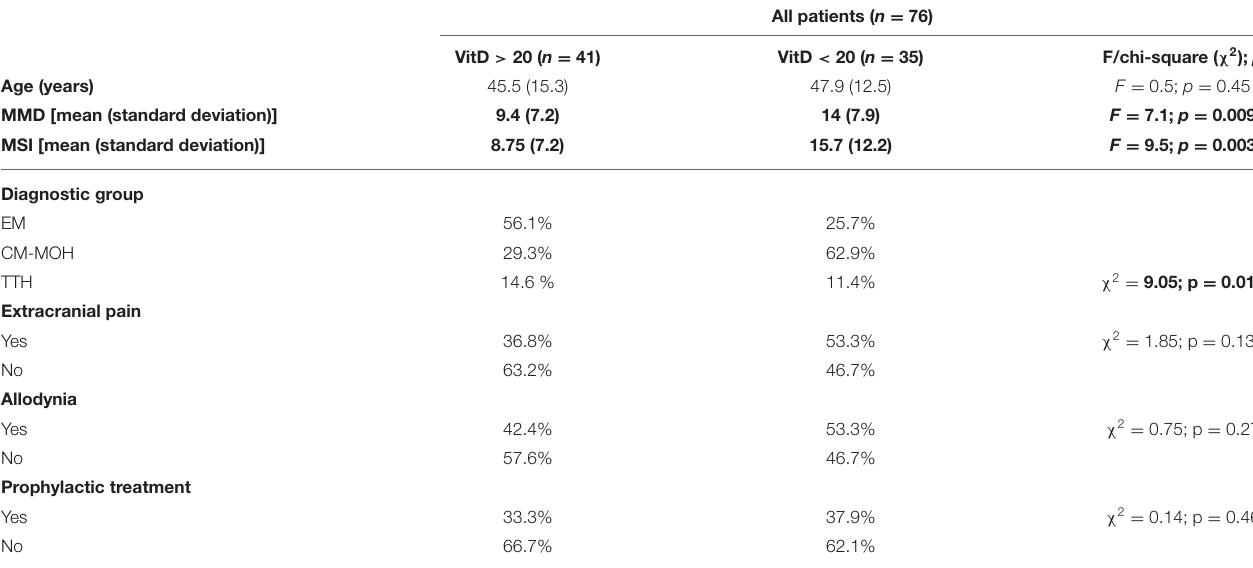
All patients ( n = 76)